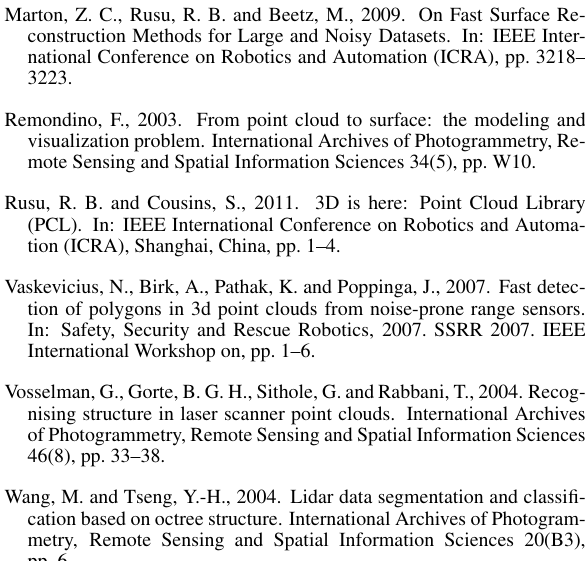
Figure 10. Parts of the polygon models and the points in the sup- port sets (thinned for visualization) for different minimal varia- tions (points of the same cell have the same